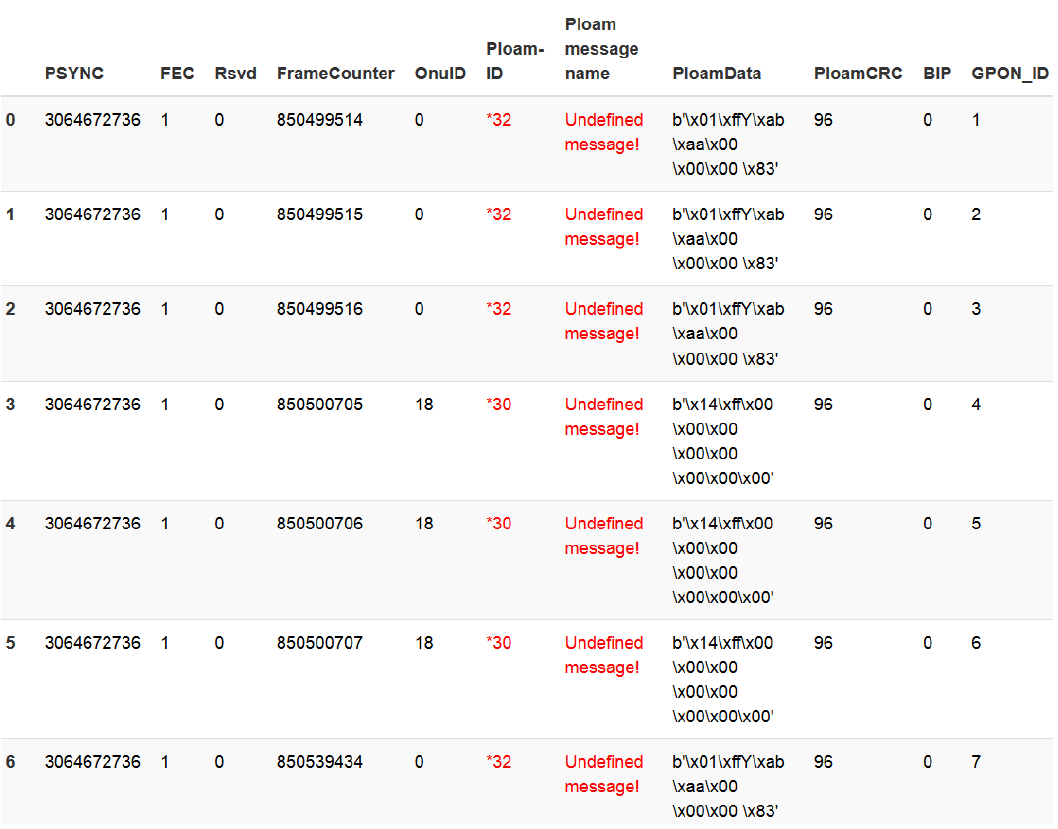
Figure 7. Hypertext markup language (HTML) output (activation